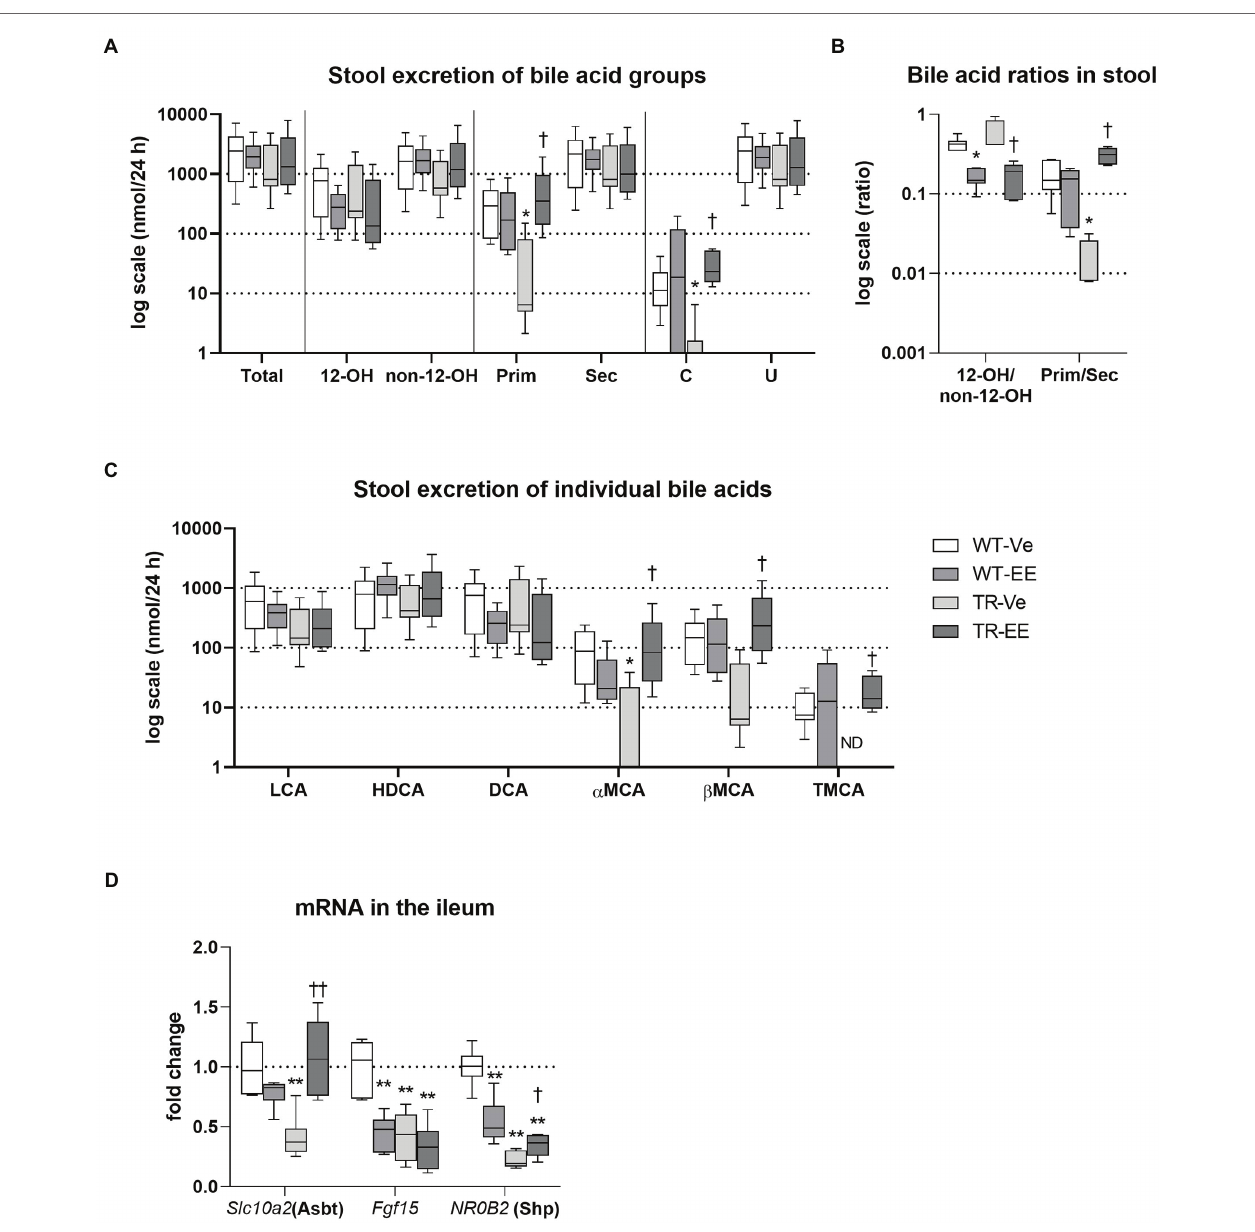
FIGURE 4 | Intestinal homeostasis of bile acids. Experimental groups: WT-Ve, WT rats receiving vehicle; WT-EE, WT rats receiving ethinylestradiol; TR-Ve, TR rats receiving vehicle; and TR-EE, TR rats receiving ethinylestradiol. BAs were analyzed in the feces collected over 24 h. (A) Stool excretion of different types of bile acids. (B) Ratios of essential bile acid groups in stool. (C) Stool excretion of individual bile acids. (D) The mRNA expression levels of essential BA transporter and regulators were analyzed in the ileum. Data are presented as median values, with boxes and whiskers representing the interquartile range and 5th-95th percentiles, respectively. Significance: * p < 0.05 and ** p < 0.01 compared to vehicle-treated WT rats. † p < 0.05 and †† p < 0.01 compared to vehicle-treated TR group. BAs are presented as follows: 12-OH, non-12-OH, Prim, Sec, C, unconjugated (U), lithocholic acid (LCA), HDCA, DCA, α muricholic acid ( α MCA), β muricholic acid ( β MCA), and